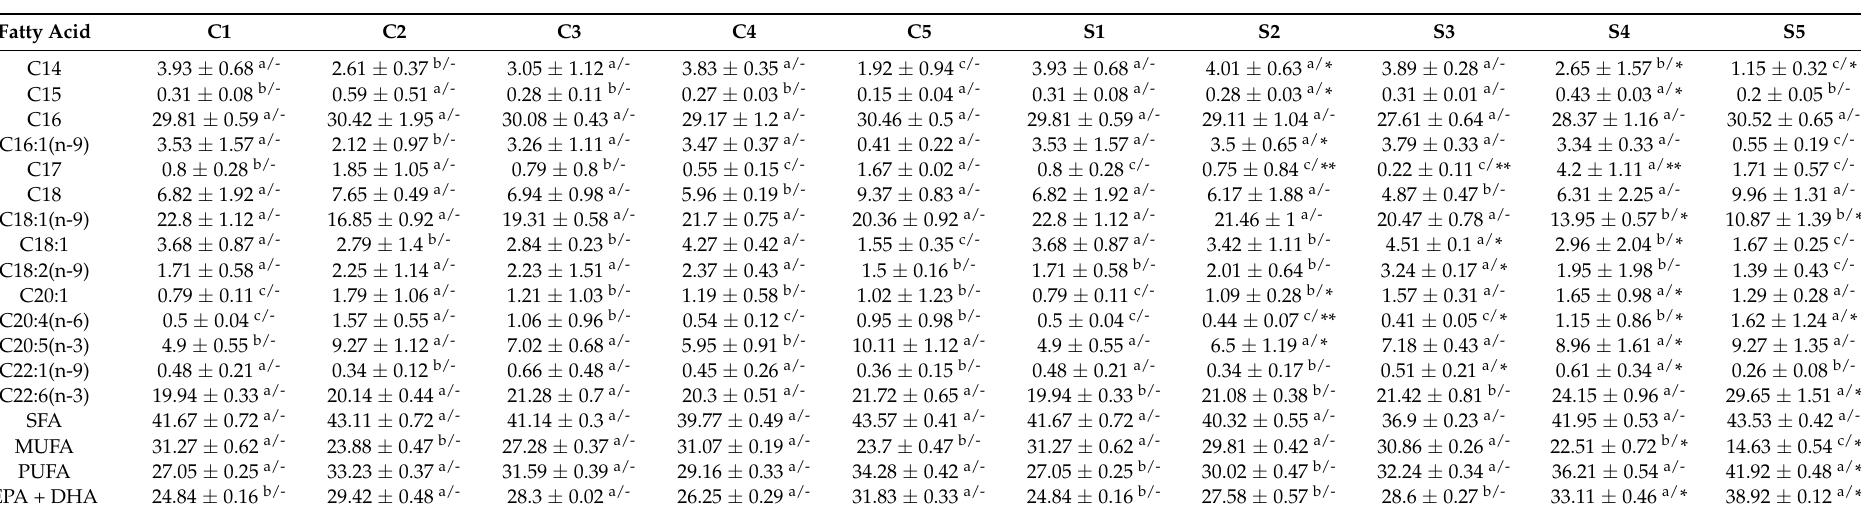
Table 2. Fatty acid composition of silver pomfret fed diets supplemented with 2% Schizochytrium sp. for 20 days (treatment group) and without Schizochytrium sp. (Control